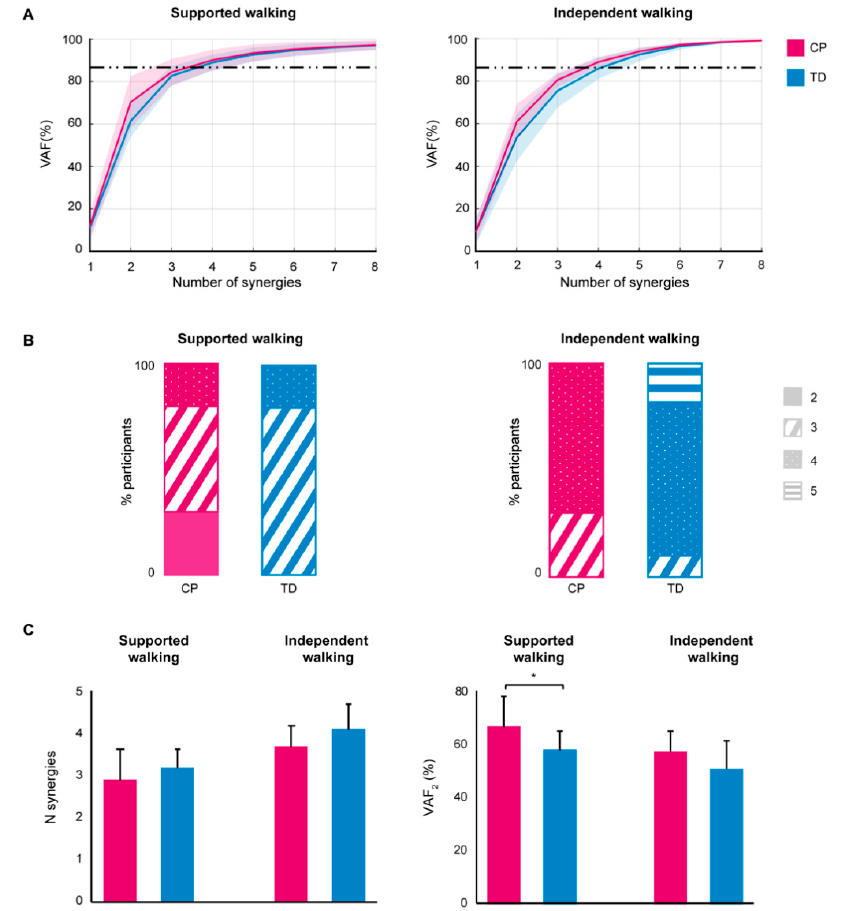
Figure 1. Bilateral EMG analysis results. ( A ) Mean variability accounted for (VAF) ± SD, per synergy 1–8 for the cerebral palsy (CP) and typically developing (TD) group, for supported walking ( left ) and independent walking ( right ); ( B ) Percentage number of synergies per group ( n = 10) based on a VAF threshold of 85% or added VAF < 8% for the CP and TD group, for supported ( left ) and independent walking ( right ); ( C ) Mean number (N) of synergies ( left ) and variability accounted for ( right ) by two synergies (VAF 2 ) for the CP and TD group, for supported walking and independent walking. Error bars indicate SDs, * p < 0.05.